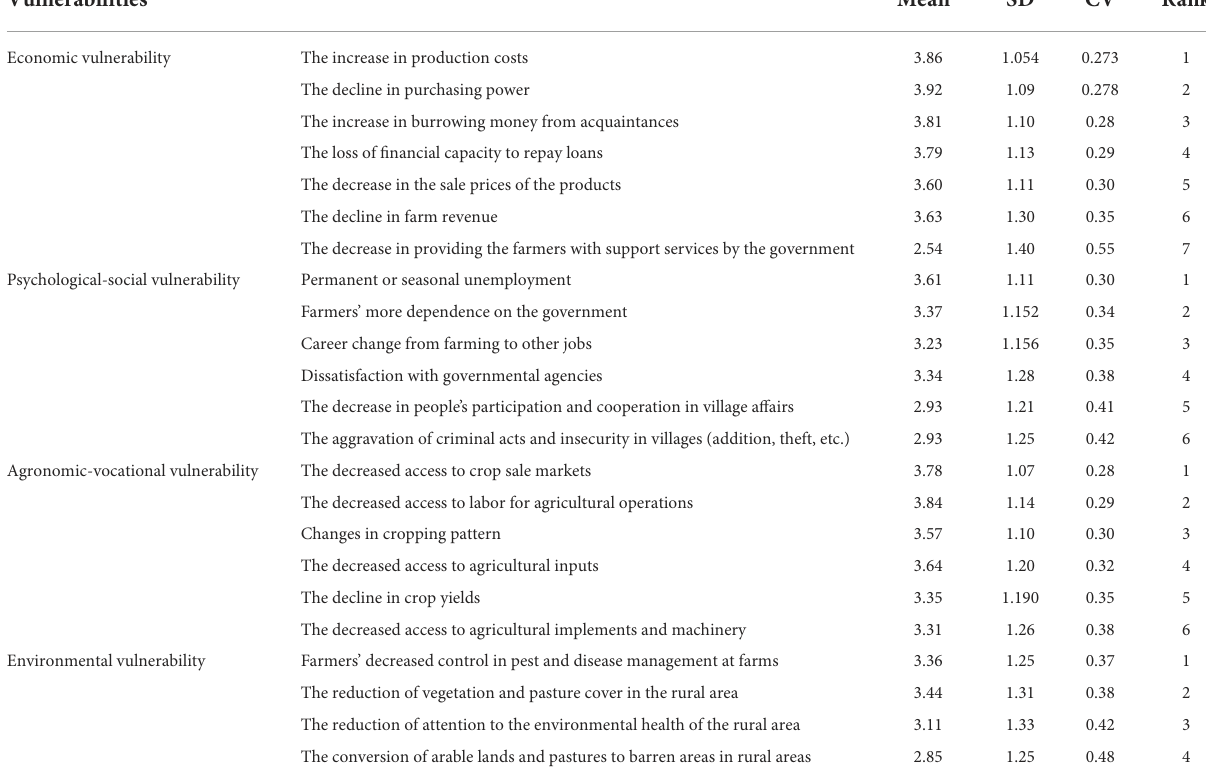
TABLE 4 The ranking of the items constituting farmers’ vulnerability to COVID-19.